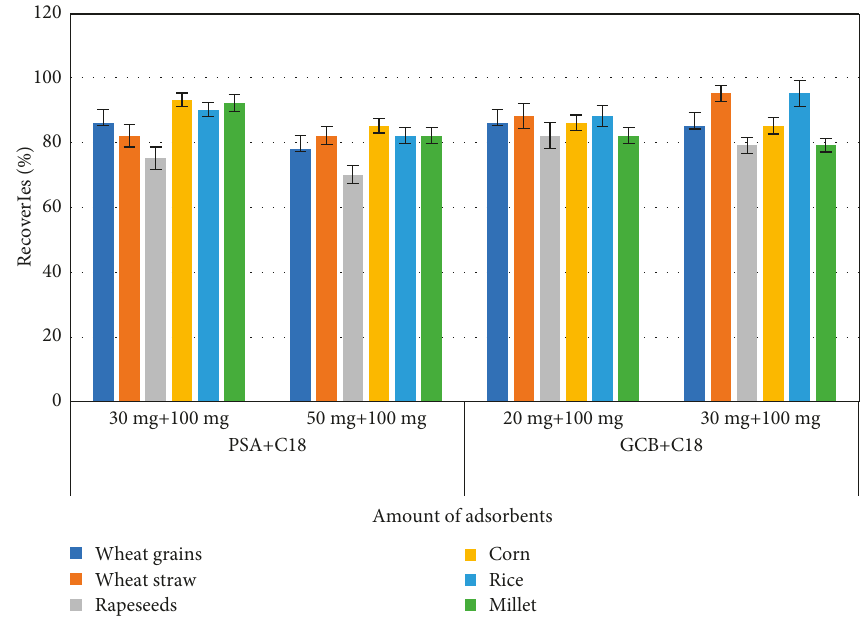
Figure 4: The recoveries of phthalanilic acid in six substrates by different adsorbents combination at the level of 0.1mg kg − 1